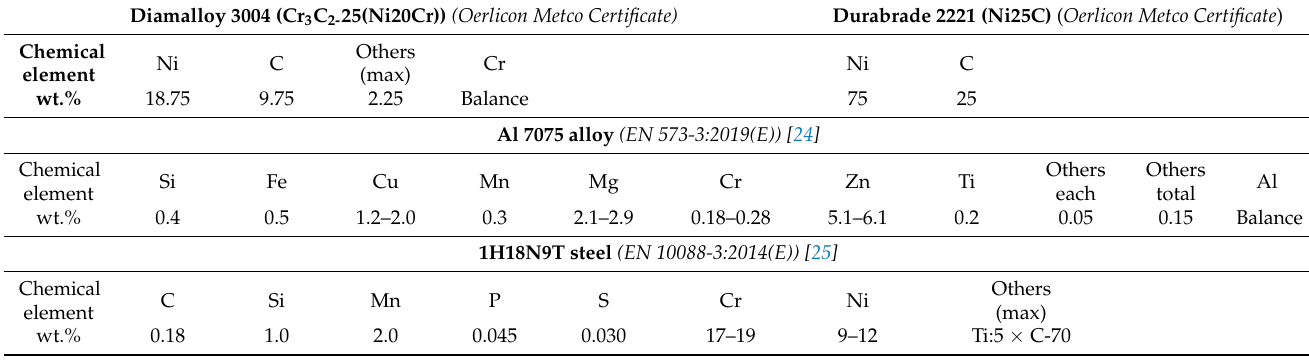
Table 1. The chemical composition (wt.%) of the powders and substrates.